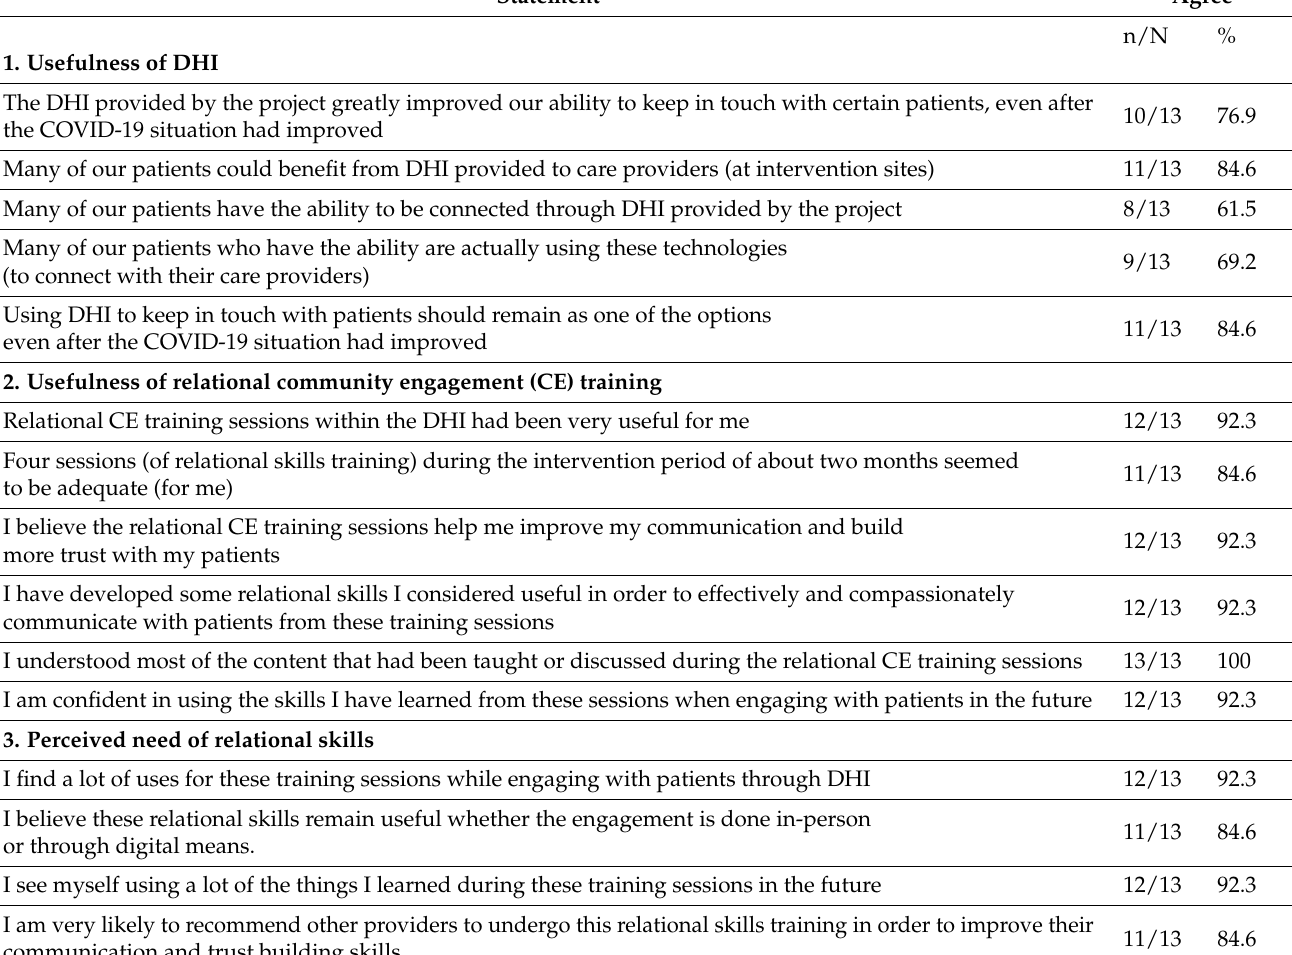
Table 2. Benefits of DHI and relational skills training with care providers from the two additional OI/ART sites, Cambodia CE research project (n = 13), Cambodia,